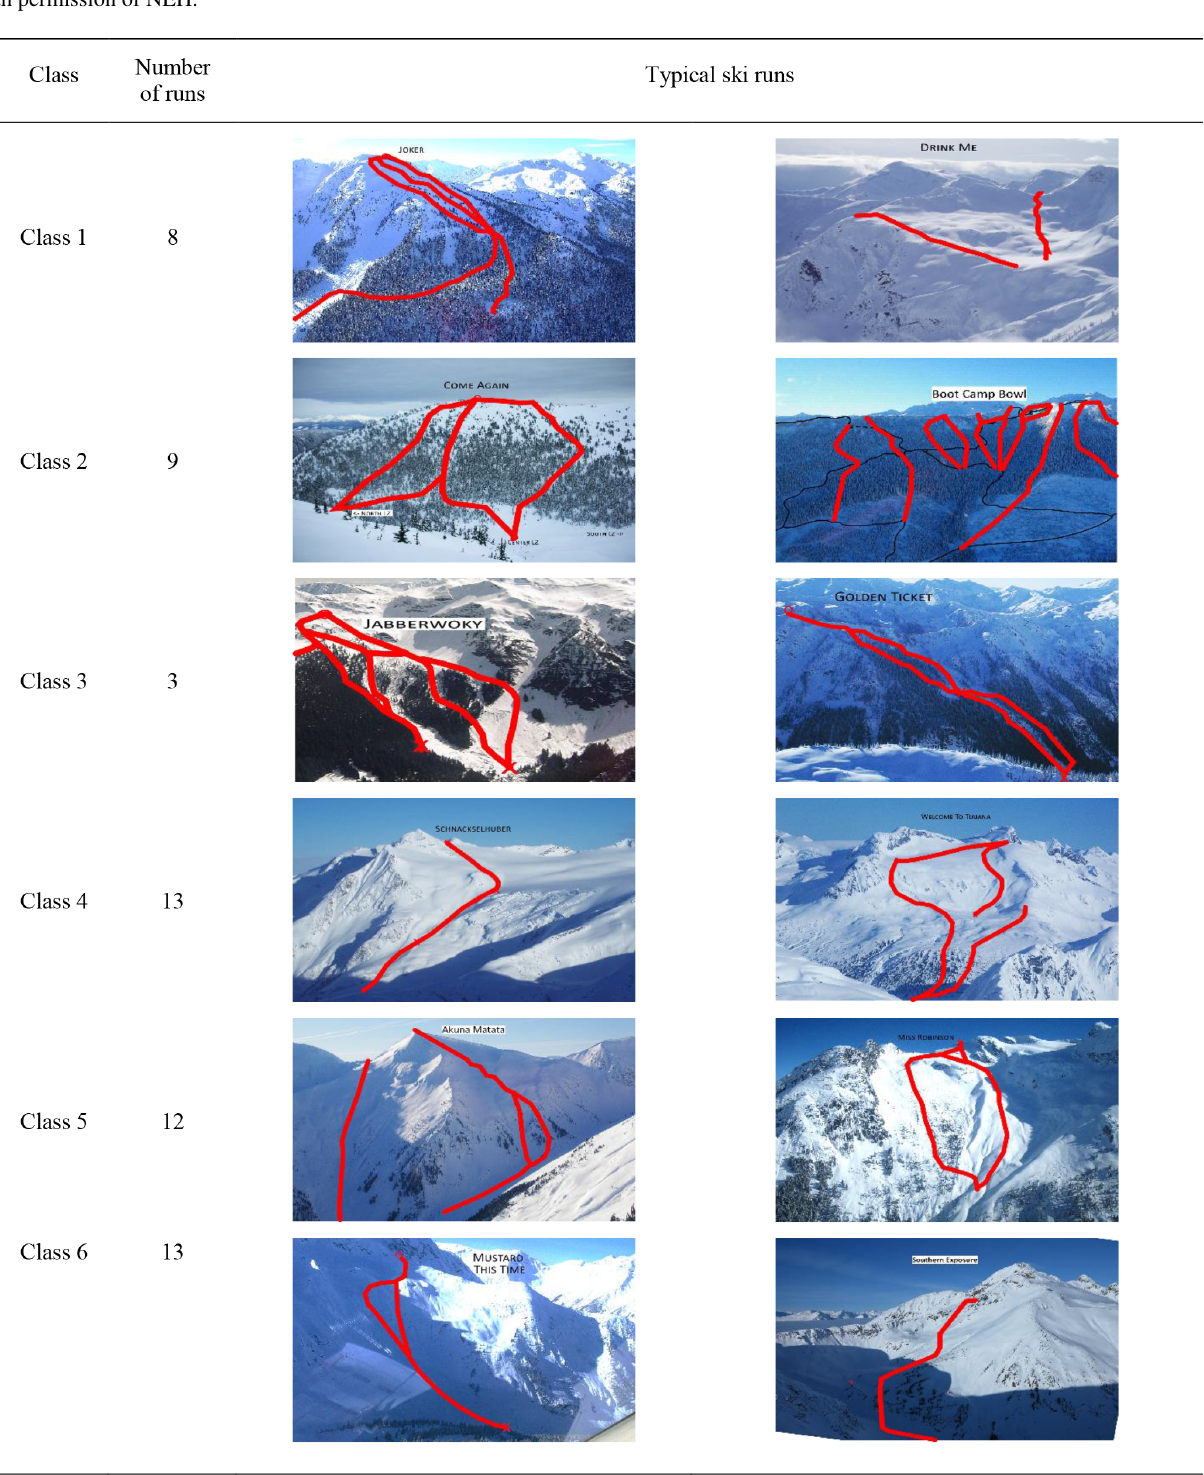
Table 1. Photos of typical ski runs for the different ski run classes including different ski line options on each run (red). All photos reproduced with permission of